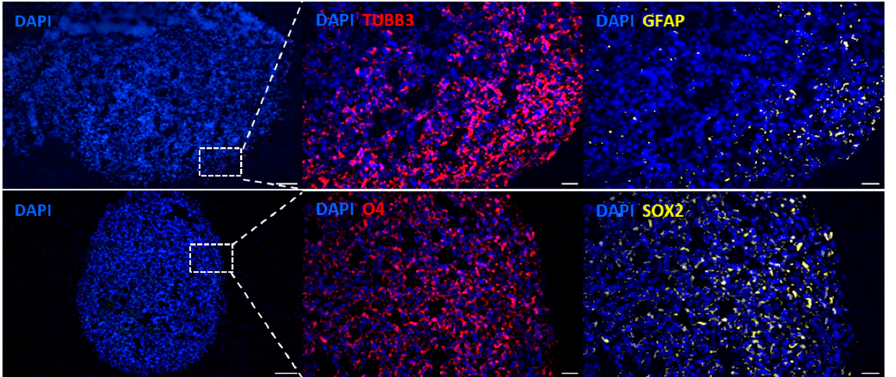
Figure 2. Immunofluorescence labeling of two differentiated organoids at day 43. The left panels show sections of organoids with blue nuclei stained with Fluoromount DAPI, scale Bar = 100 µm (10×). The dashed-line square represents the field visualized at higher magnification in the subsequent panels. The upper figures show the presence of neurons TUBB3 (red) and astrocytes GFAP (yellow). The bottom panels show oligodendrocytes O4 (red) and embryonic stem cells SOX2 (yellow). Scale bar 20 µm (40×).